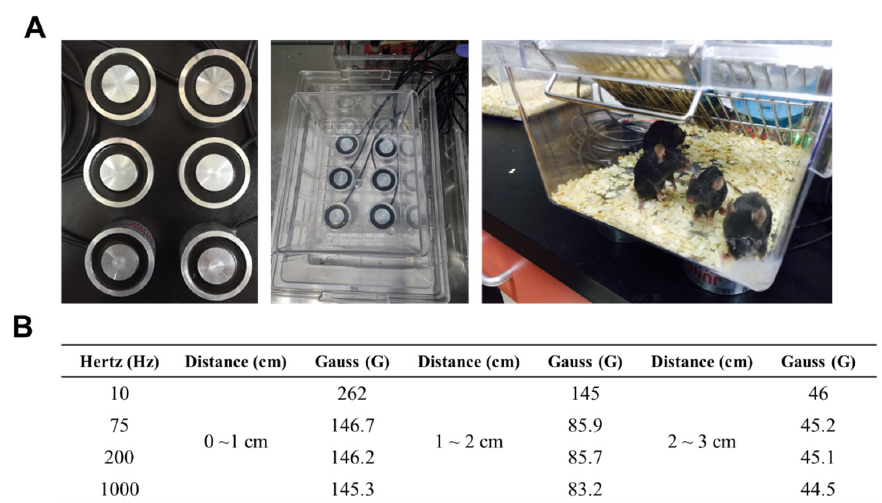
Figure 1. PEMF device. ( A ) PEMF-generating device showing the 6-channel magnetic coils (left). The coils are placed under the housing cage (middle) and five mice are housed in each cage (right). ( B ) Hertz and Gauss levels generated as assessed from the upper surface of the PEMF coils.